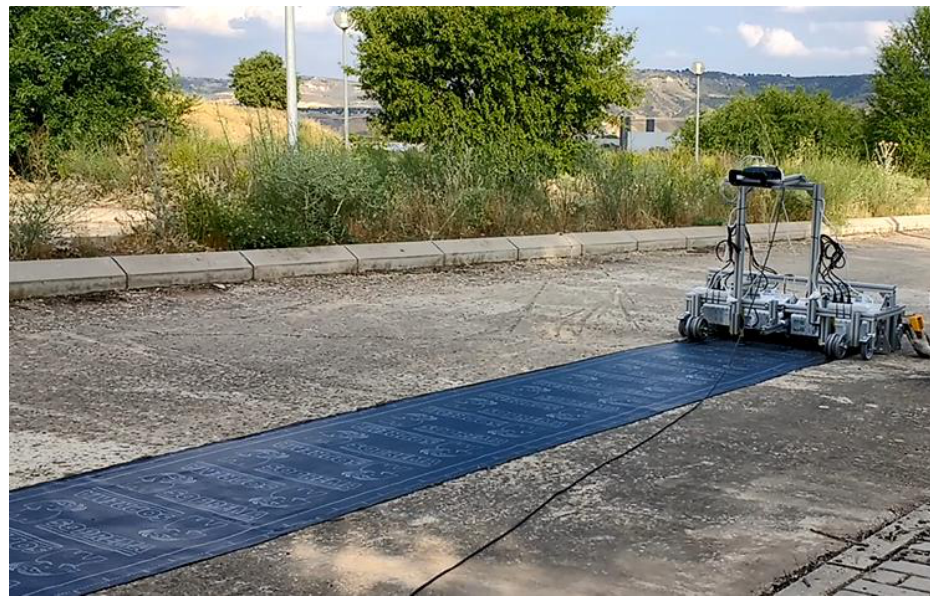
Figure 22. Asphalt roll installation.